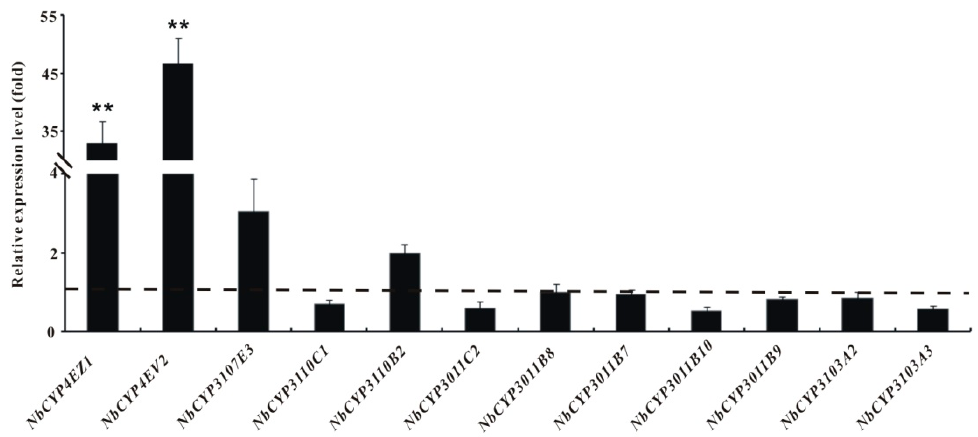
Figure 4. Fold-expression changes in selected P450s in the fenpropathrin resistant N. barkeri strain relative to its susceptible strain. Bars represent mean ± standard deviation. Asterisks indicate significant differences by t -test, ** p < 0.01.